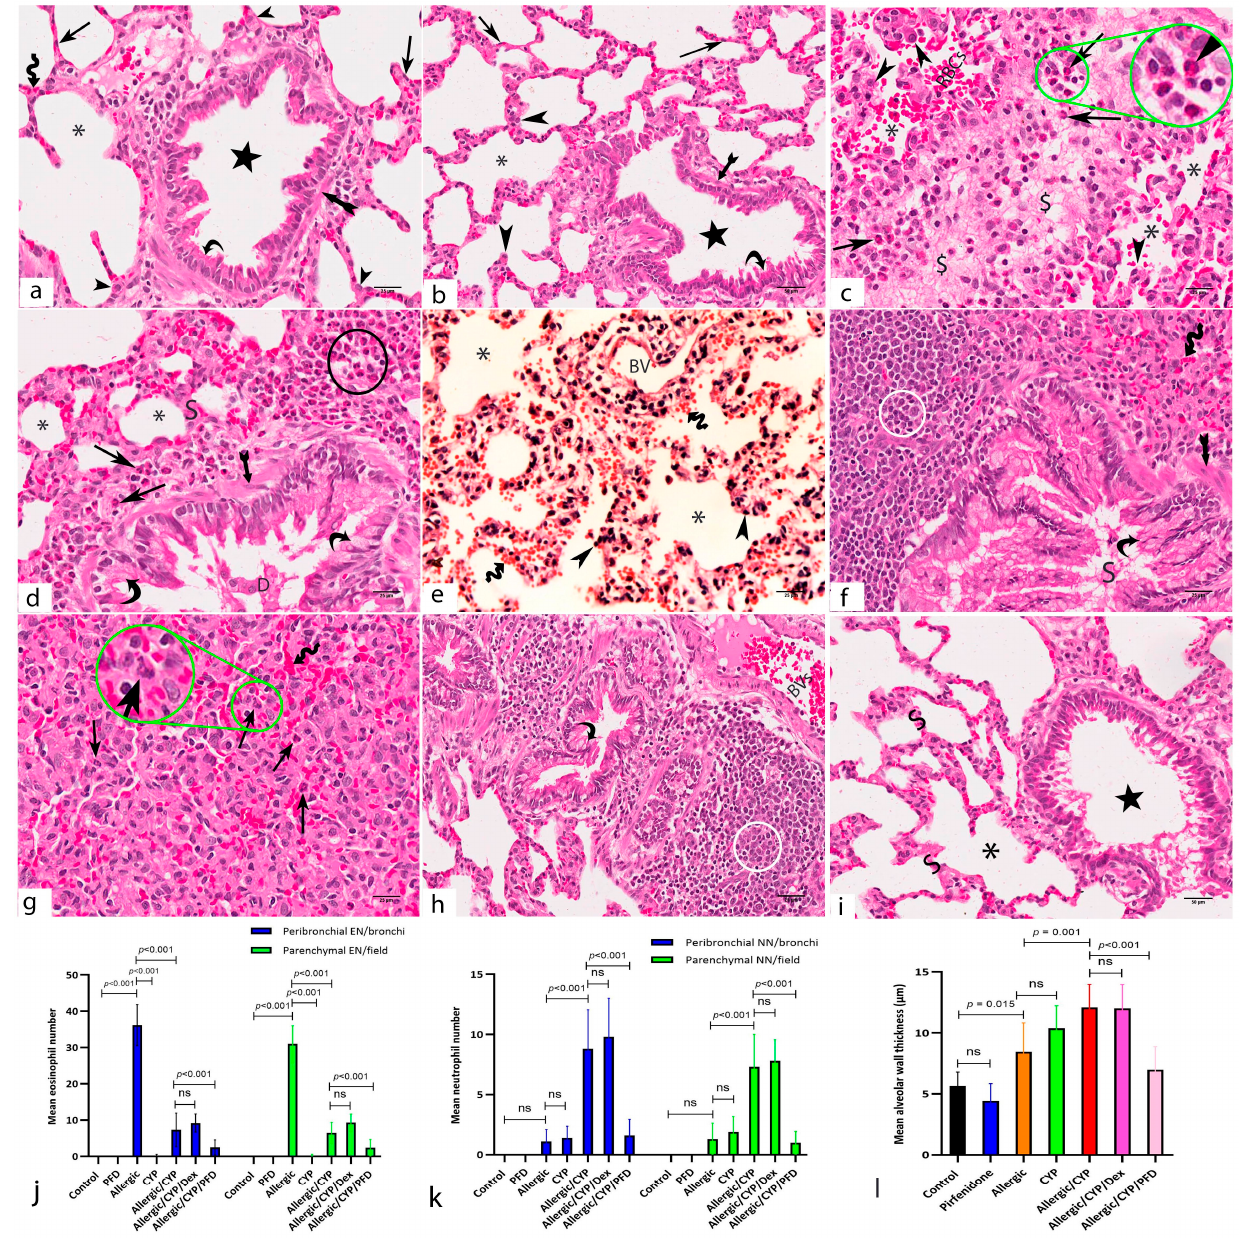
Figure 3. Photomicrographs of H&E-stained lung sections of the study groups. ( a , b ) control and pirfenidone alone-treated groups, respectively, show normal histological structure of the lungs. Alveoli (asterisks) are lined by thin type I (arrows) and thick type II (arrowheads) pneumocytes. Thin interalveolar septa are seen containing blood capillaries (zigzag arrows). Bronchioles (star) are lined by columnar cells (curved arrow) with thin underlying smooth muscle layers (arrow with tails). ( c , d ) Allergic pneumonitis group shows narrowed alveoli (asterisks) and thick interalveolar septa (S) infiltered by mononuclear inflammatory cells (circle), mainly eosinophils (arrows). Interalveolar edema (dollar sign) and massive interalveolar eosinophil infiltration (arrows) are prominent. Many alveoli are distorted with hypertrophic cell lining (arrowheads). Intra-alveolar red blood cells (RBCs) and vascular congestion are evident. The bronchioles show a thickened smooth muscle layer (arrows with tail), eosinophil infiltration (arrow), and hypertrophied folded epithelium